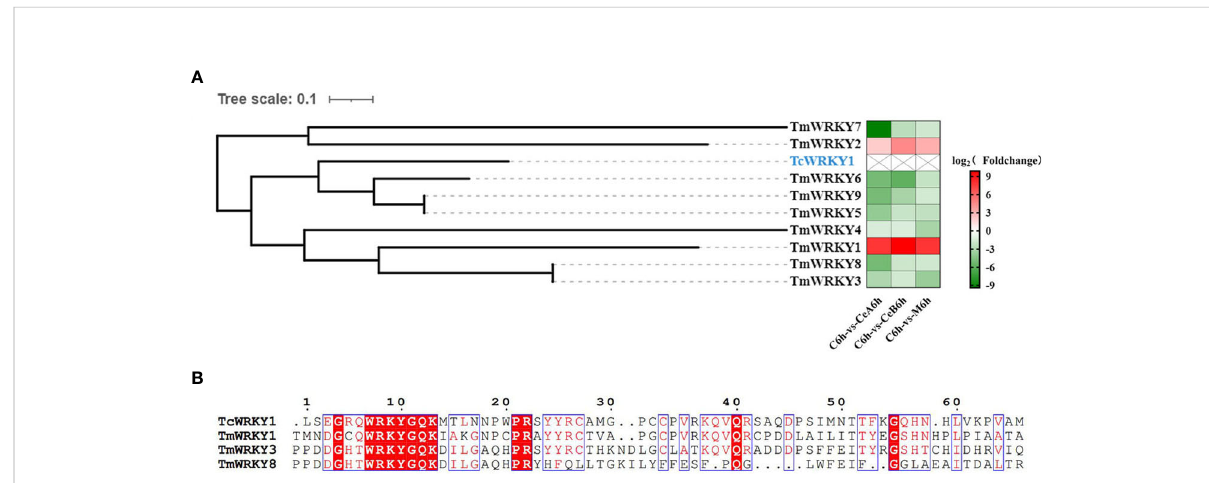
FIGURE 10 (A) hylogenetic analyses of WRKY coding genes. Protein marked in blue represent the WRKY that participated in the regulation of taxol biosynthesis pathway. The color density indicated log2 (Foldchange). Red indicated the upregulation of gene expression and green indicated the downregulation of gene expression. (B) Multiple sequence alignments of the WRKY domains of three TmWRKYs and